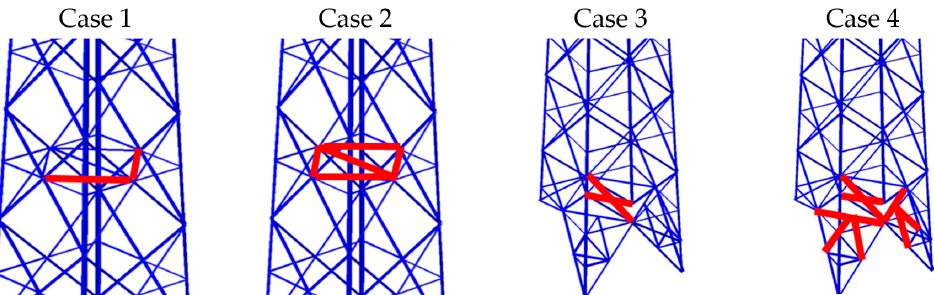
Figure 23. Highlighted: the removed secondary structural elements. Case 1 has 2 braces missing from the 5th level; Case 2 had 5 missings (the entire secondary structural reinforcement section); Case 3 had 2 braces missing from the 1st level; and Case 4 had 8 elements from the same level missing (in the legs).